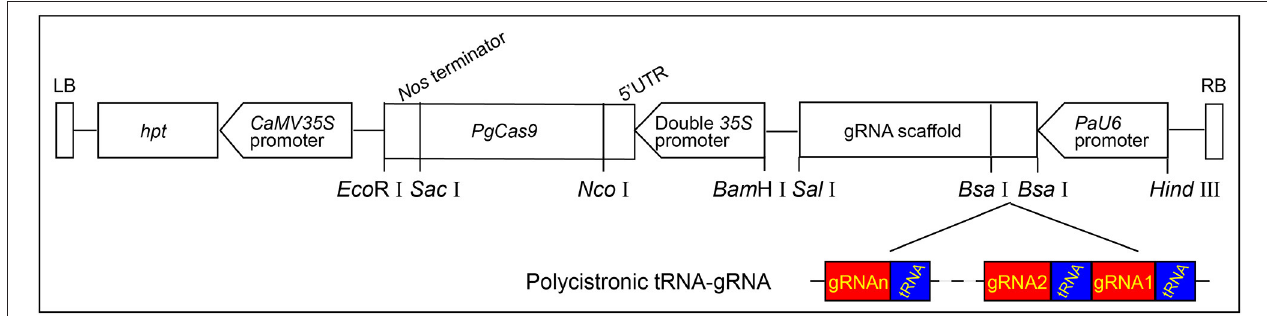
FIGURE 1 | The T-DNA structure of PgCas9 / PaU6 . The hygromycin phosphate transferase ( hpt ) gene, which was driven and terminated by the CaMV35S promoter and the CaMV35S polyA, respectively, was used as the selective marker gene. The PgCas9 with a nuclear localization signal (NLS) at each side of 5 ′ and 3 ′ ends was driven by the doubled 35S promoter and terminated by the Nos terminator. The PaU6 promoter was used to drive the expression of polycistronic tRNA-gRNA (PTG), and two Bsa I sites were designed between the PaU6 promoter and the gRNA backbone for assembling the PTG into the binary vector. Eco RI, Sac I, Nco I, Bam HI, Sal I, and Hind III were restriction enzymes. The left and right borders of T-DNA were designated as LB and RB, respectively.